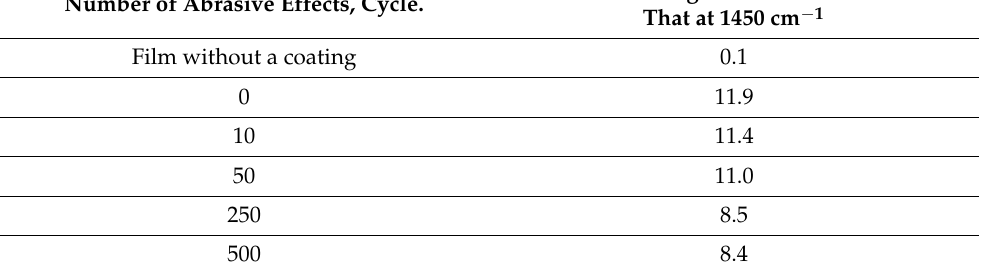
Table 4. Effects of abrasion on the PTFE content on the surface of an oriented PP film (according to the IR spectra). Number of Abrasive Effects, Cycle.